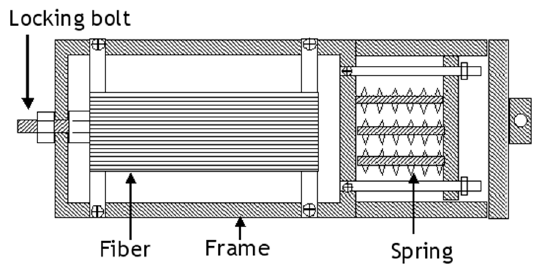
Figure 6. Schematic illustration of the fibre pre-stressing rig developed by Zhao and Cameron; this rig was used in combination with a hot-press [42].